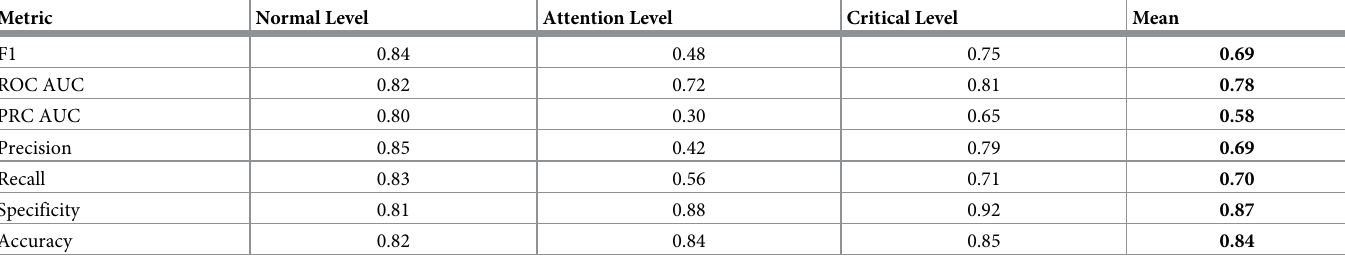
Table 9. Consolidated metrics of the